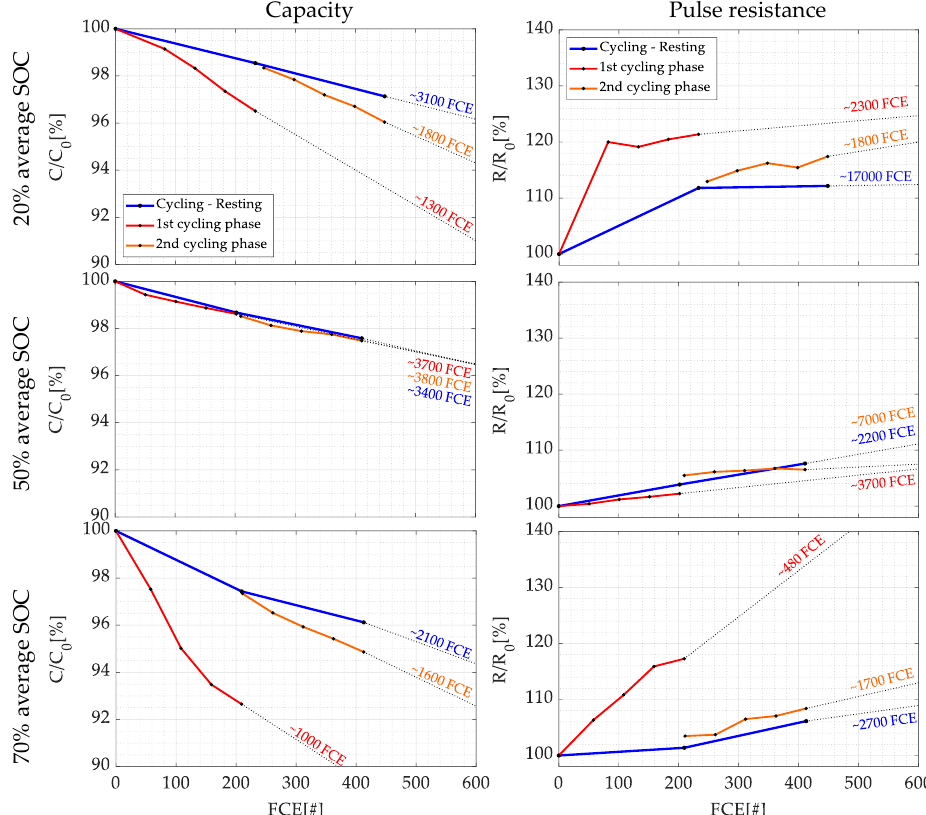
Figure 10. Capacity loss and resistance increase rate for cells cycled at 20%, 50% (reference), and 70% average SOC. The aging rate during the 1st and 2nd cycling phases is plotted in red and orange, while the blue line depicts the aging with recovery effect during resting pauses. A prognosis is depicted with a black dotted line and the approximate FCE count for reaching the end-of-life criterion.